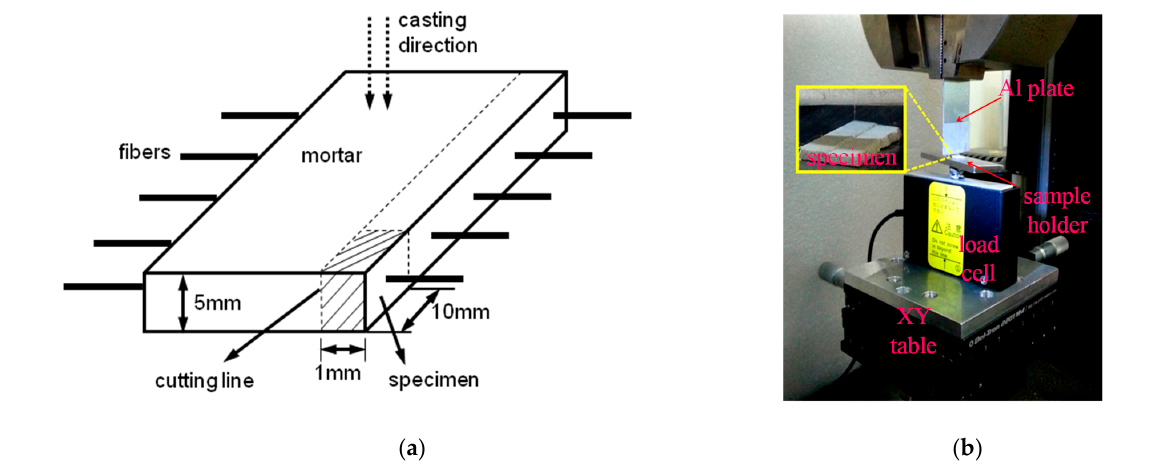
Figure 5. (a) Specimen and (b) test apparatus for single fiber pullout test. Figure 5. ( a ) Specimen and ( b ) test apparatus for single fiber pullout